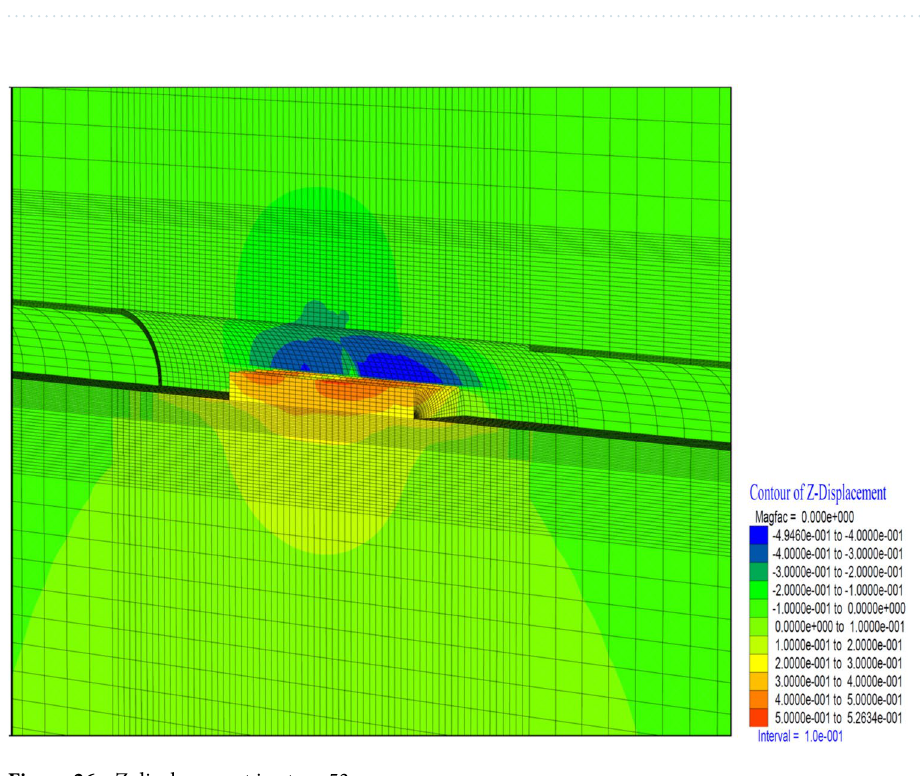
Figure 26. Z displacement in stage